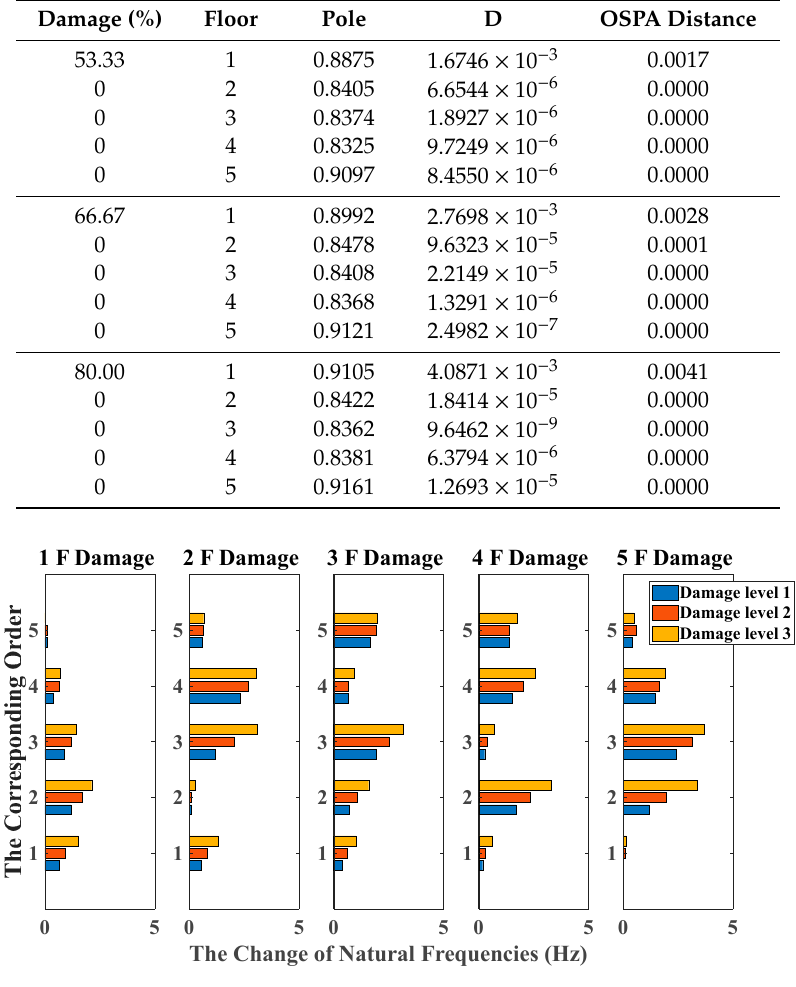
Figure 17. Damage detection results based on the change of natural frequencies (sine sweeping-frequency excitation, data length = 4000). Sensors 2019 , 19 , x FOR PEER REVIEW